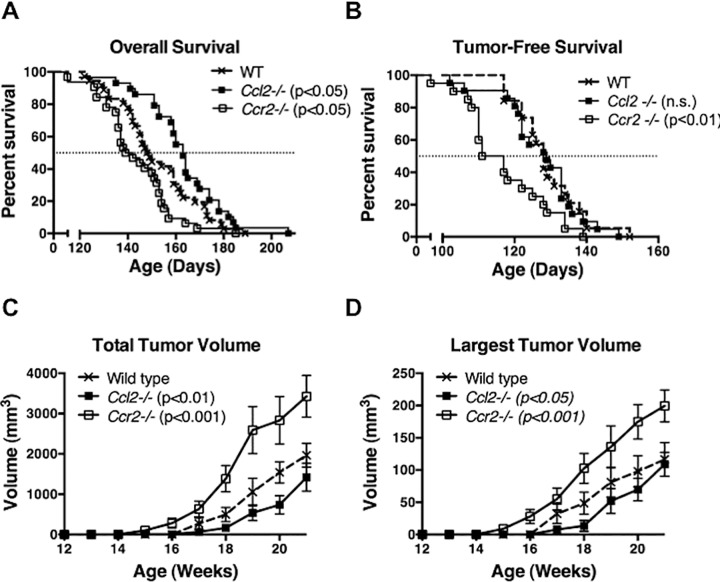
Effect of genetic disruption of Ccl2 or Ccr2 on Her2/neu-driven mammary carcinoma development.(A and B) Overall survival and tumor-free survival of neu+ (n = 36), neu+Ccl2-/- (n = 29), and neu+Ccr2-/- (n = 32) mice. Median survivals were compared using Log-rank (Mantel-Cox) test; (A) p < 0.05 for both wild type versus Ccl2-/- and wild type versus Ccr2-/-; (B) not significant (n.s.) wild type versus Ccl2-/-, p < 0.01 wild type versus Ccr2-/-. (C and D) Growth of Her2/neu-driven mammary carcinoma in wild type, Ccl2-/- and Ccr2-/- mice measured as total tumor volume in a mouse (C) or as the volume of the single largest tumor mass in a mouse (D). Because the stochastic risk of malignant transformation is the same for any mammary epithelial cell in this model, multiple tumor masses were often observed in single mammary glands. Thus the total tumor volume in a mouse (C) could exceed the theoretical limit of ten times the single largest tumor mass (D) (based on ten mammary glands per mouse). Different strain backgrounds produced no differences in the number of tumors per mouse. Comparisons were made by two-way ANOVA; (C) p<0.05 Ccl2-/-
versus wild type, p<0.001 Ccr2-/-
versus wild type; (D) p<0.05 Ccl2-/-
versus wild type, p<0.001 Ccr2-/-
versus wild type.